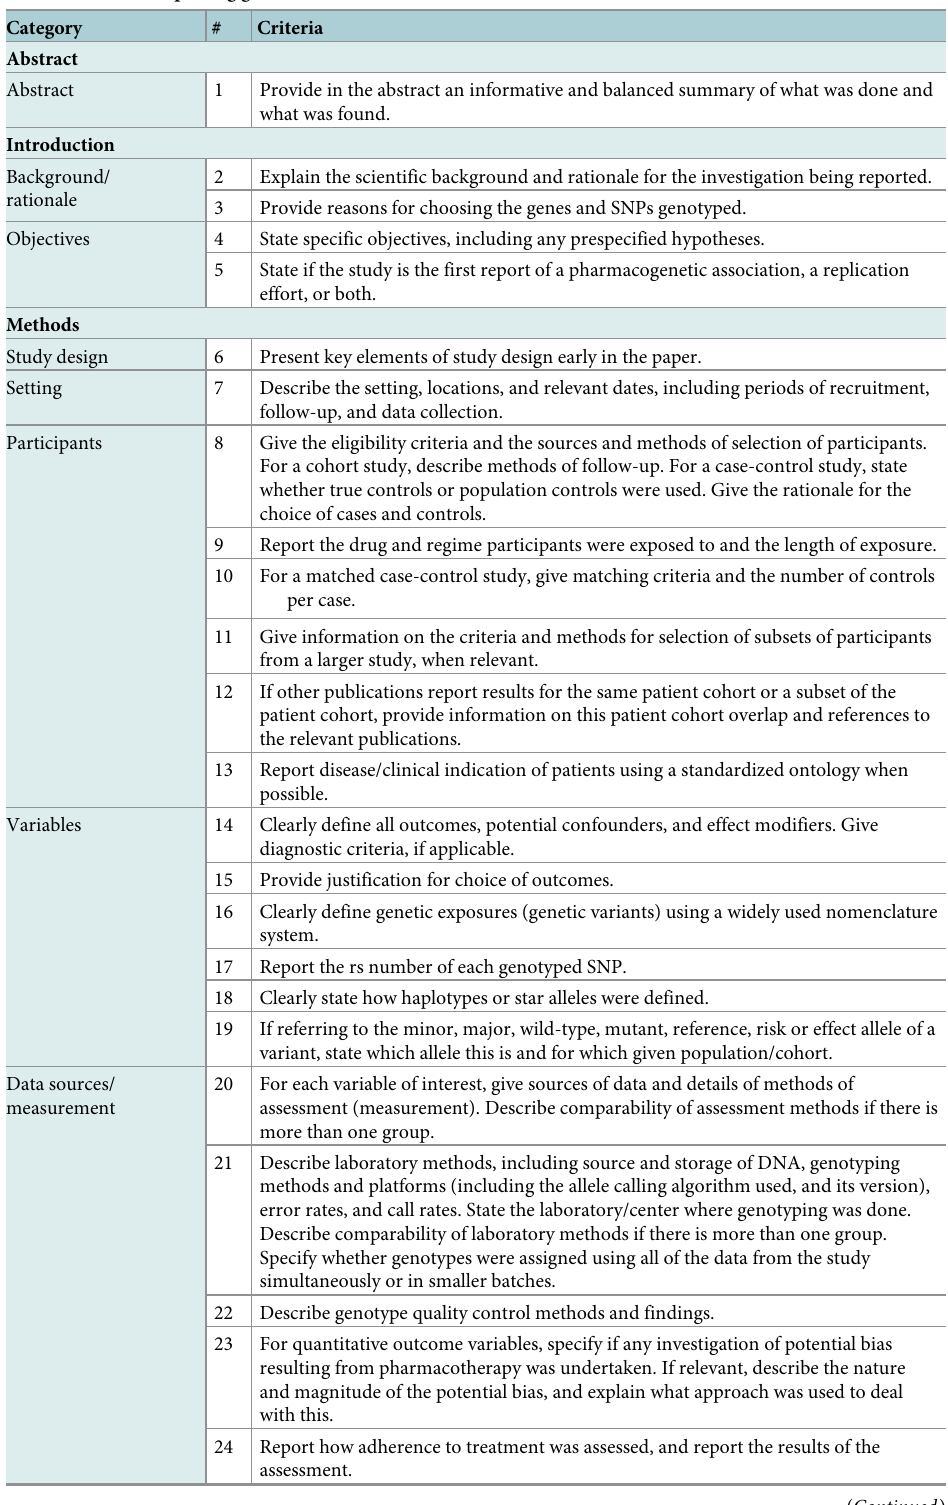
Table 1. STROPS reporting